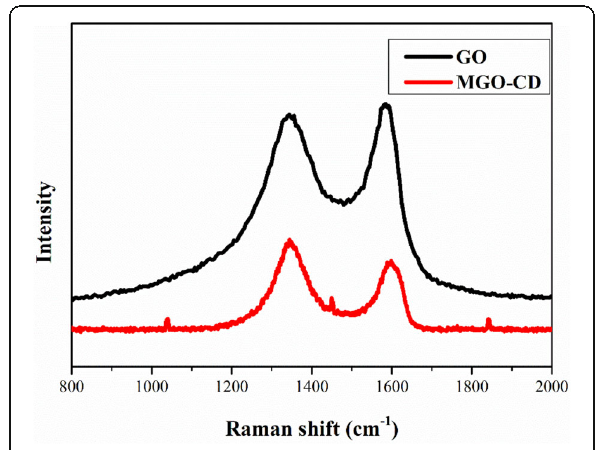
Fig. 5 Raman spectra of GO and